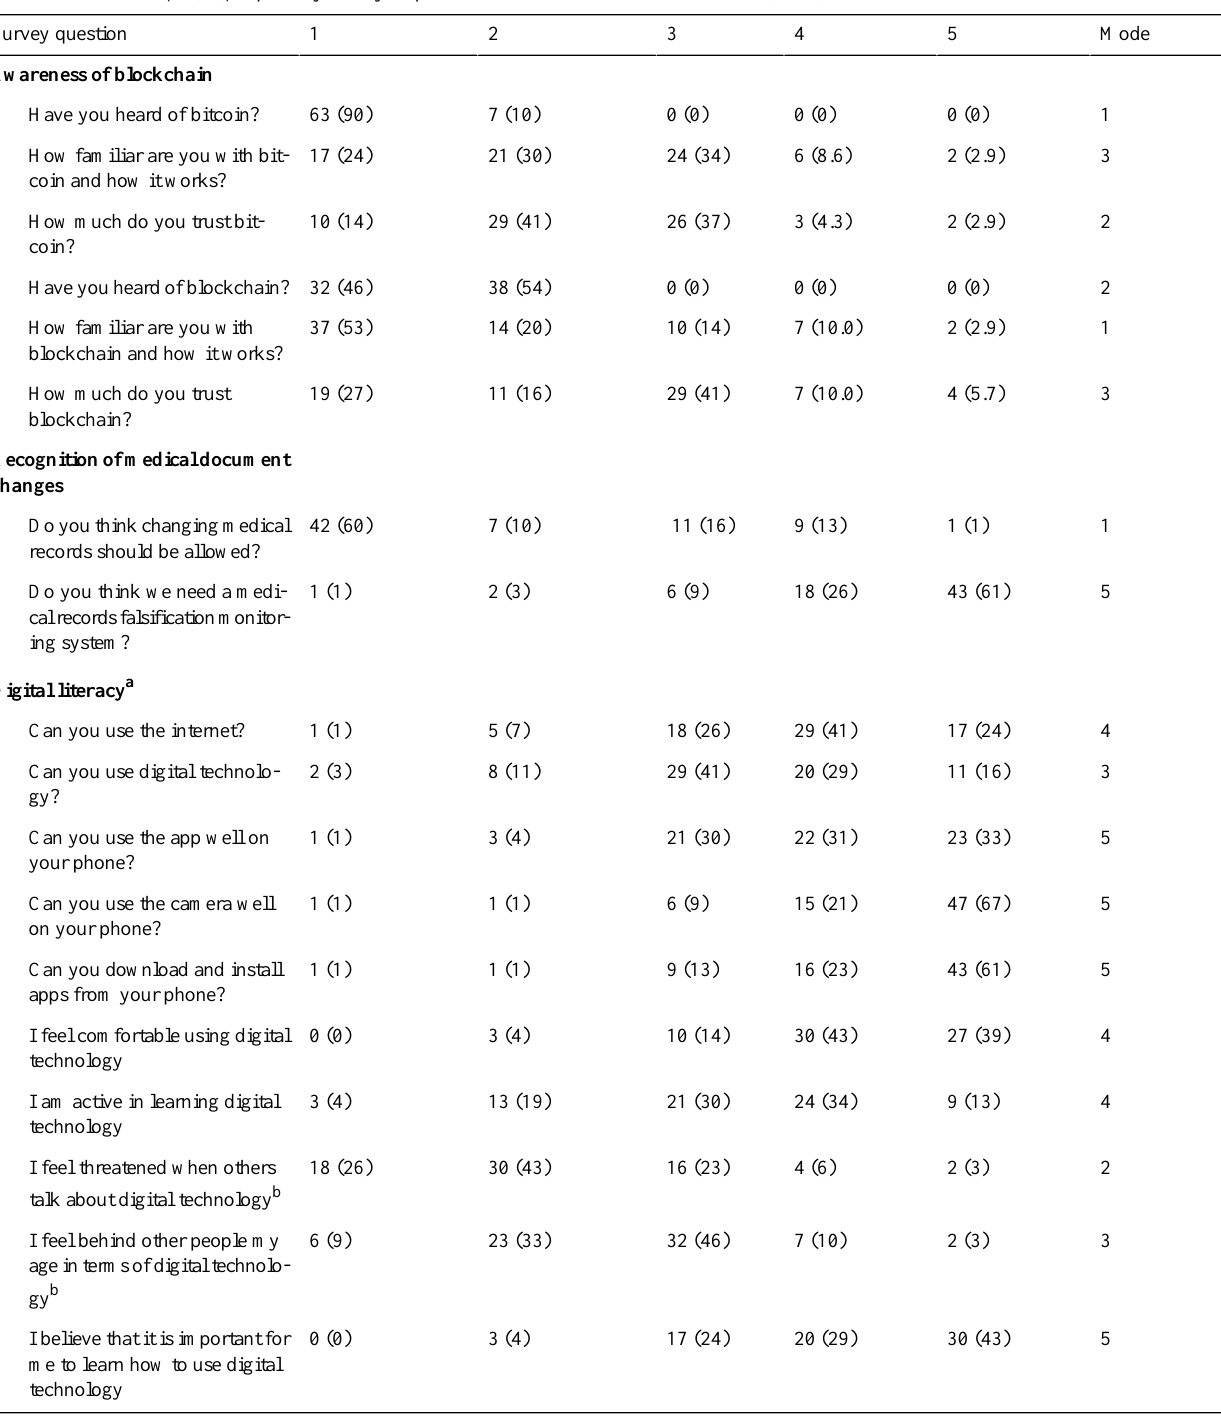
a A high score represents a high level of digital literacy, unless otherwise indicated. b A low score represents a high level of digital health